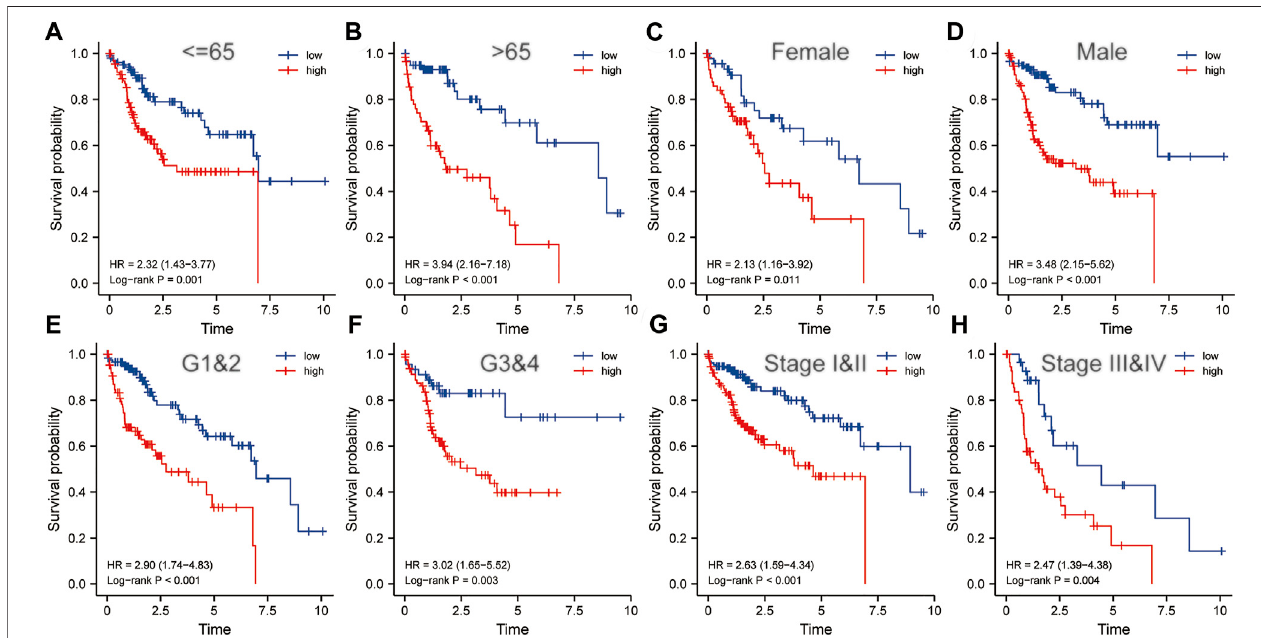
FIGURE 8 | The risk score was an important indicator of poor prognosis in each subgroup divided by clinicopathological characteristics. In various subgroups divided by clinicopathological characteristics including age (A,B) , gender (C,D) , grade (E,F) and pathological stage (G,H) , the prognosis of the high-risk groups was poorer than that of the low-risk groups. HR, risk